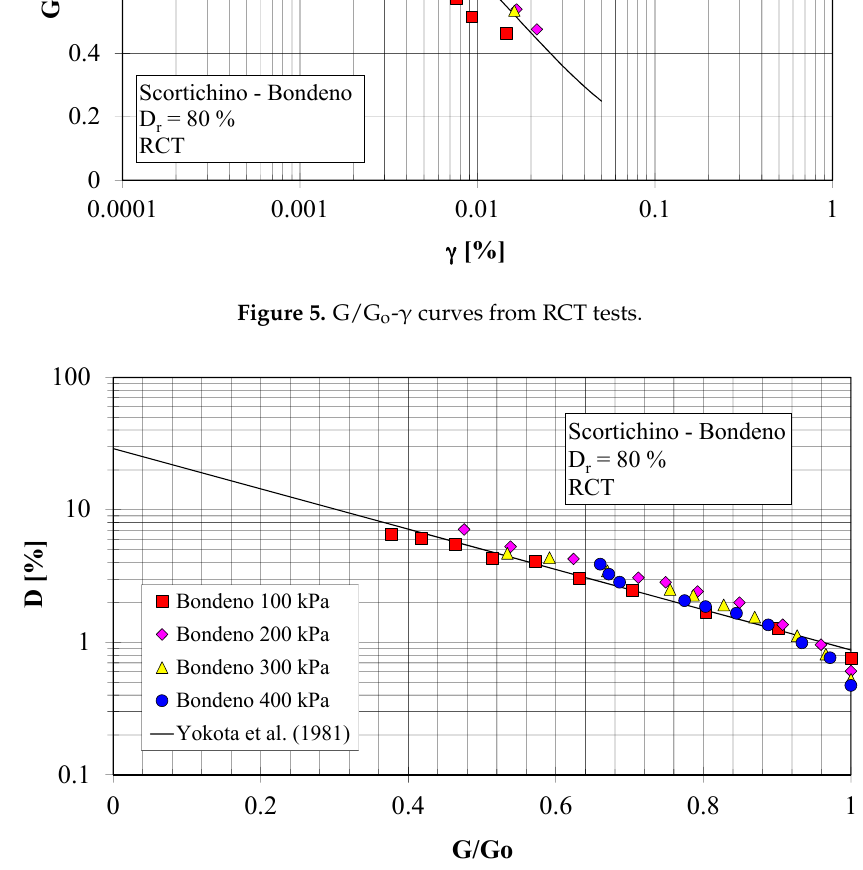
Figure 6. D-G/G o curves from RCT tests.